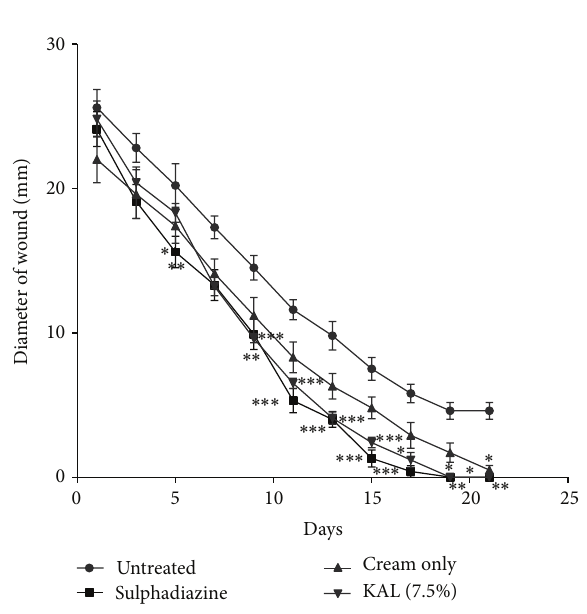
Figure 6: Influence of methanol leaf extract (KAL) cream (7.5% w/w)of K.africana ontherateofclosureofwounds.Valuesare diameter of wounds expressed as mean ± SEM ( 𝑁 = 5 ). ∗ 𝑃 < 0.05 , ∗∗ 𝑃 < 0.01 , and ∗∗∗ 𝑃 < 0.001 . Control is the untreated wounds. 1% w/w silver sulphadiazine was used as positive